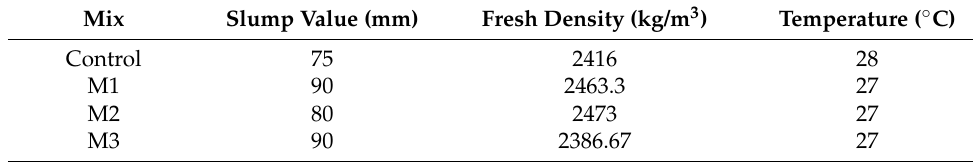
Table 4. Concrete properties in a fresh